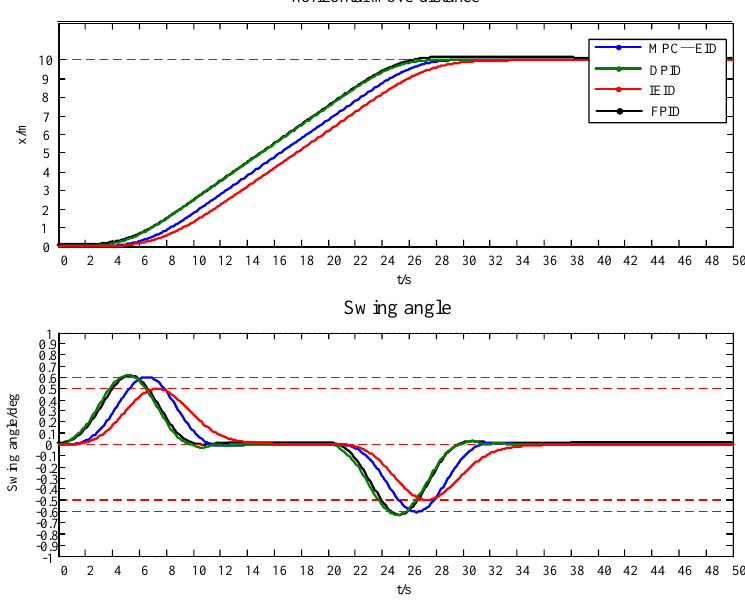
Figure 8. Result of simulation 4.